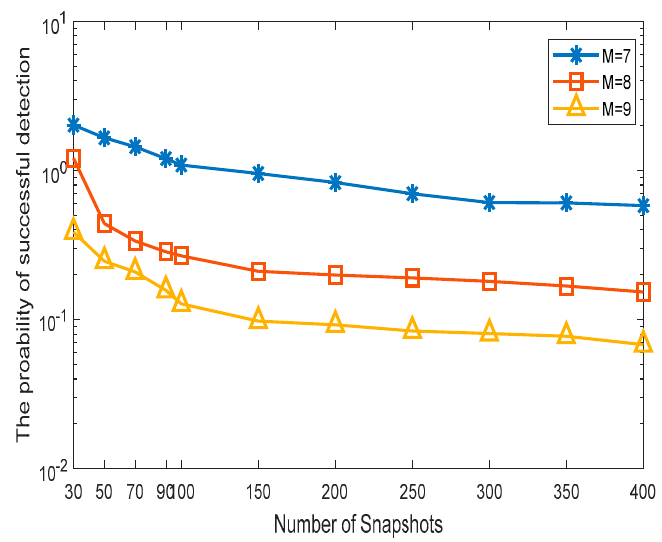
Figure 4. RMSE versus different antennas under different SNRs ( T = 300).